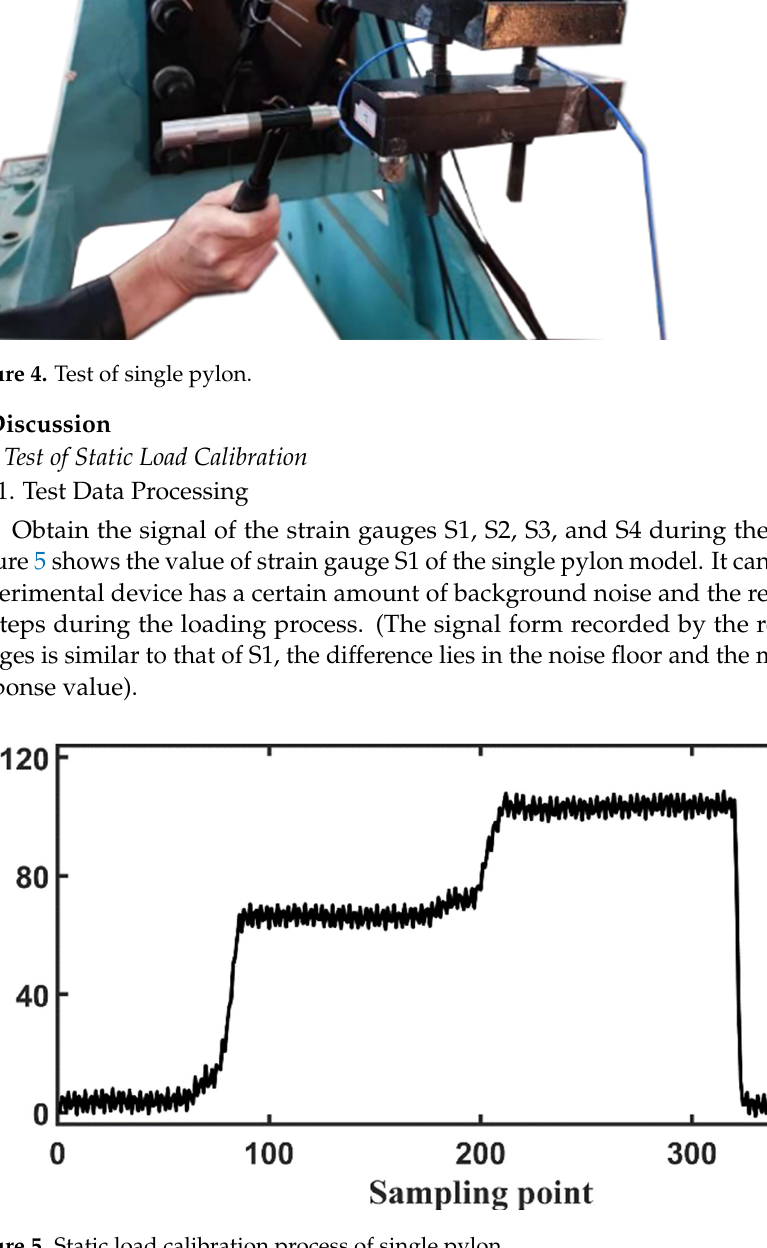
Figure 5. Static load calibration process of single pylon.